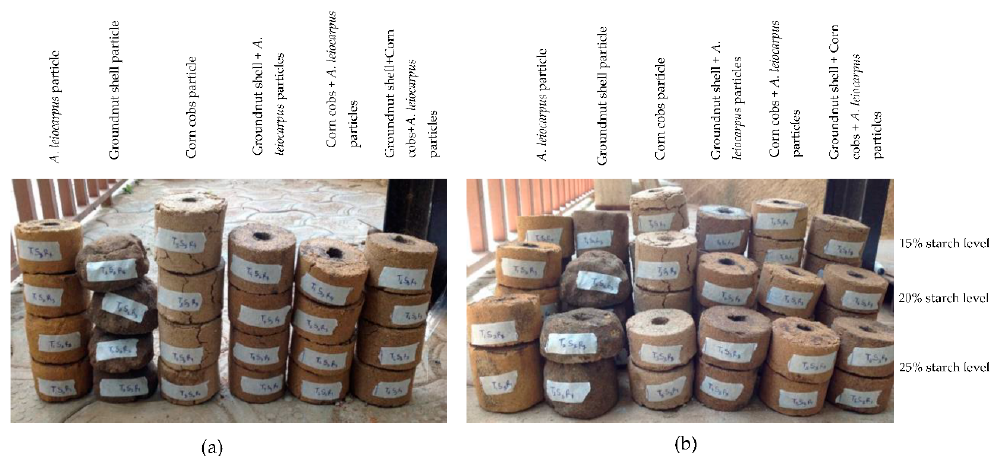
Figure 2. ( a ) Briquettes produced based on particle types; ( b ) Briquettes produced based on particle types and starch levels.